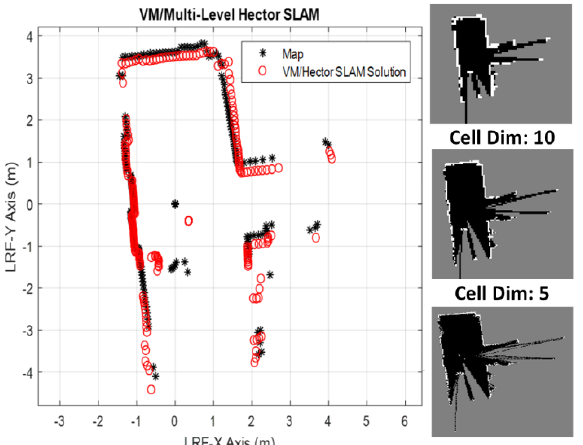
Figure 5. VM/ Multi-level Hector SLAM performance (first